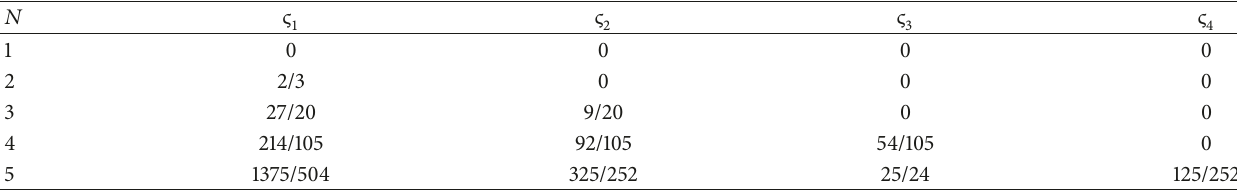
Table 3: Optimized coefficients of different